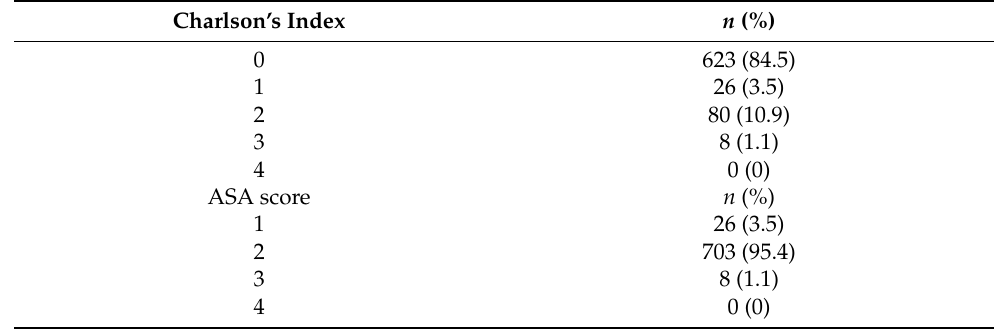
Table 2. Charlson’s Comorbidity Index and ASA